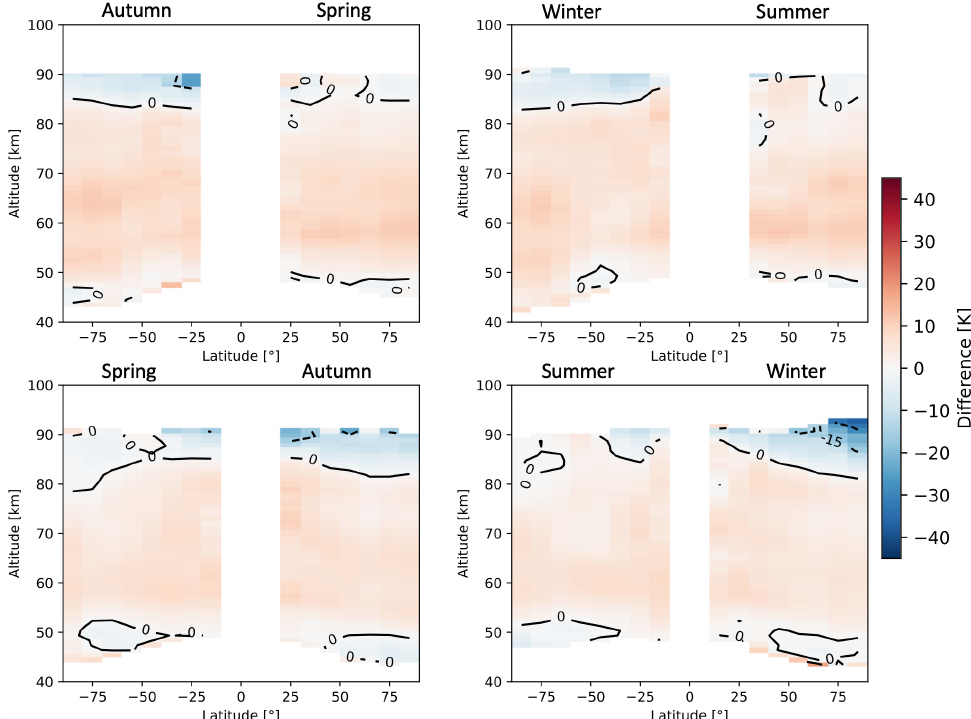
Figure A30. Seasonal zonal means of temperature FM13 SMR–MLS absolute differences averaged over the time period between July 2004 and April 2019. The seasons are intended as astronomical seasons, i.e. each starting at the respective solstice or